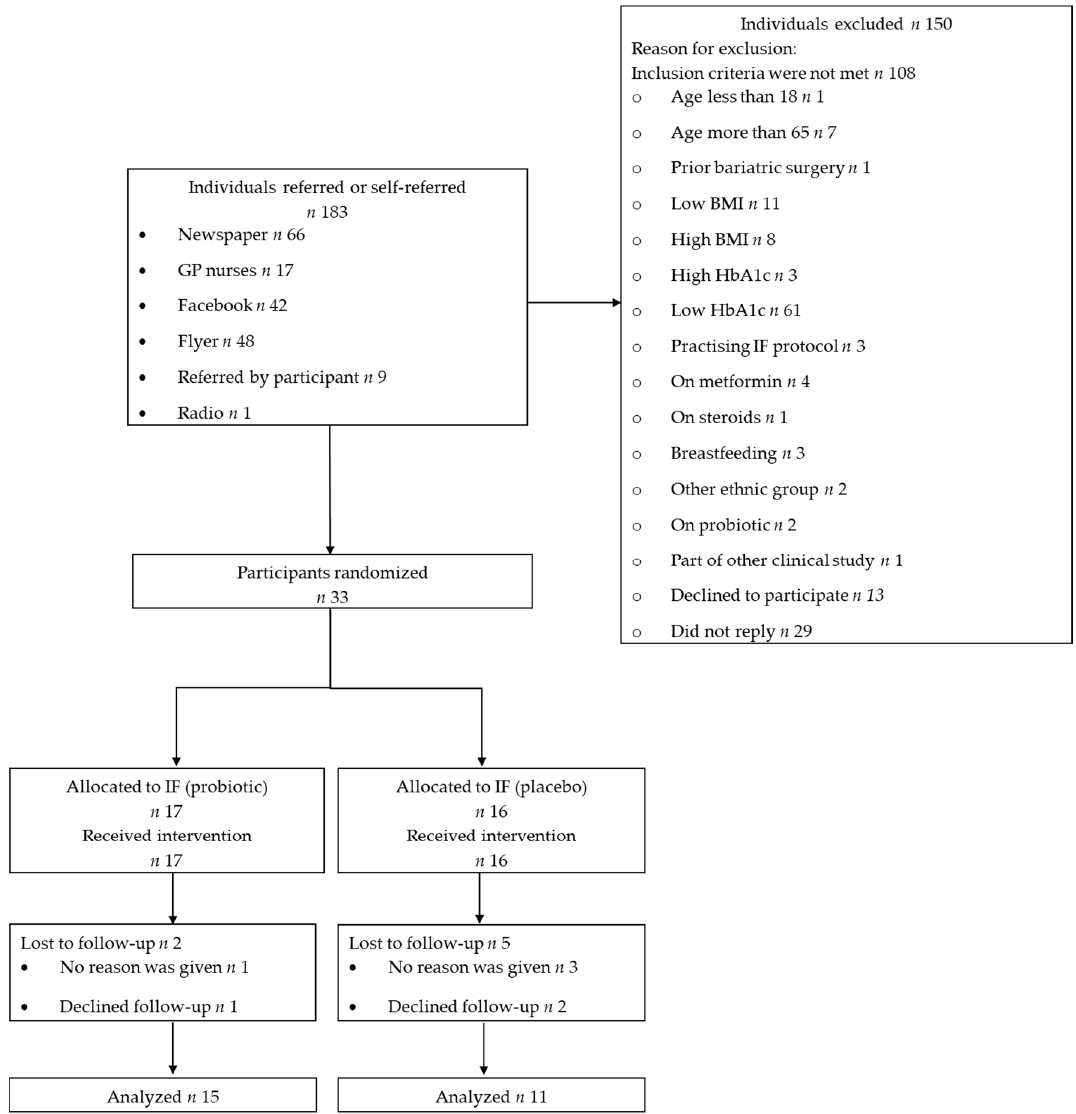
Figure 1. Consort diagram detailing participant numbers from recruitment to analysis. Abbreviations: BMI, body mass index; IF, intermittent fasting; GP, General Practice.